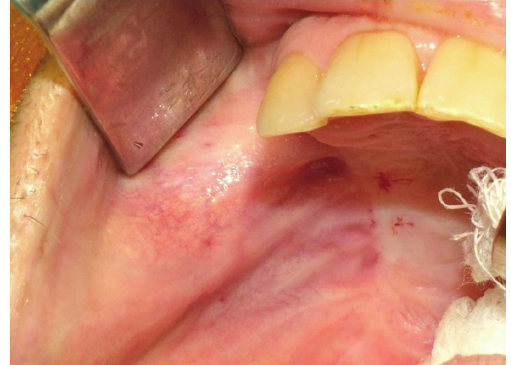
Figure 1: Preoperative intraoral view.